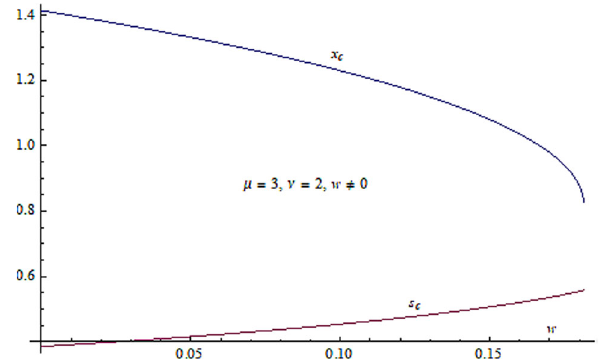
Fig. 2 Behavior of f ( x ; s ) for fixed values of parameter s < s c and w = 0, μ = 3 ,ν = 2